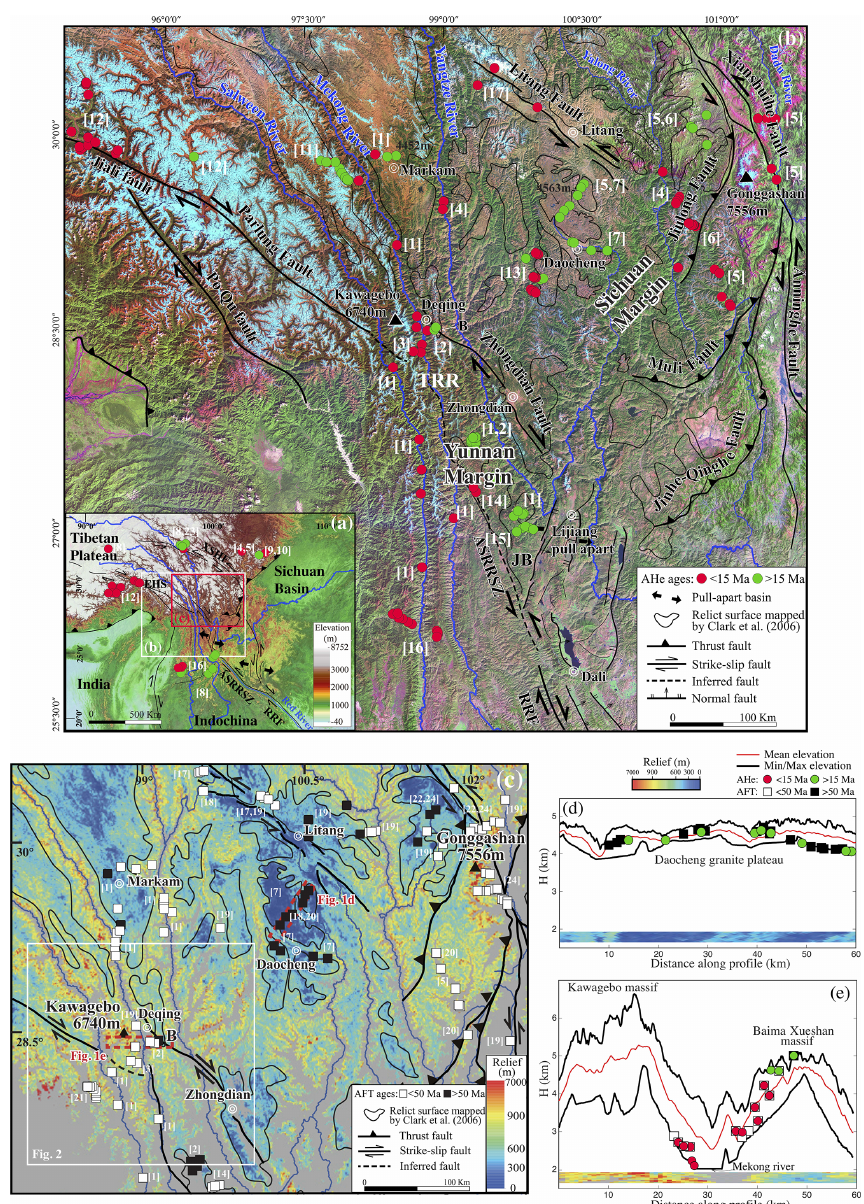
Figure 1. Tectonic and geomorphic setting of south-east Tibet. (a) Topography and tectonic framework of the central and eastern Tibetan Plateau, based on the GTOPO30 digital elevation model (DEM). White box shows extent of Fig. 1b; red box shows extent of Fig. 1c. (b) Main faults, rivers, relict surfaces, and apatite (U–Th) / He (AHe) data, overlain on Landsat image mosaic of south-east Tibet (USGS). (c) Relief map (modified from Zhang et al., 2015), derived from 30m resolution DEM; 1km radius relief is shown for pixels at elevations > 3500m above sea level. Black outlines delimit low-relief relict surfaces with relief < 600m, as mapped by Clark et al. (2006). Note that some averaging of the relief across the relict surface and active landscape occurs at the edges of the relict surface. In these areas local relief can be as high as 1km. Two red rectangles represent topographic profile and relief shown in (d) and (e) . (d, e) Topographic profiles across Daocheng granite plateau and Kawagebo and Baima Xueshan massifs, respectively, showing local topography and relief with available thermochronometric ages. Note that these two panels share the same legend. Apatite (U–Th) / He (AHe) and apatite fission track (AFT) ages are from [1] Yang et al. (2016), [2] Liu-Zeng et al. (2018), [3] Replumaz et al. (2020), [4] Ouimet et al. (2010), [5] Clark et al. (2005),